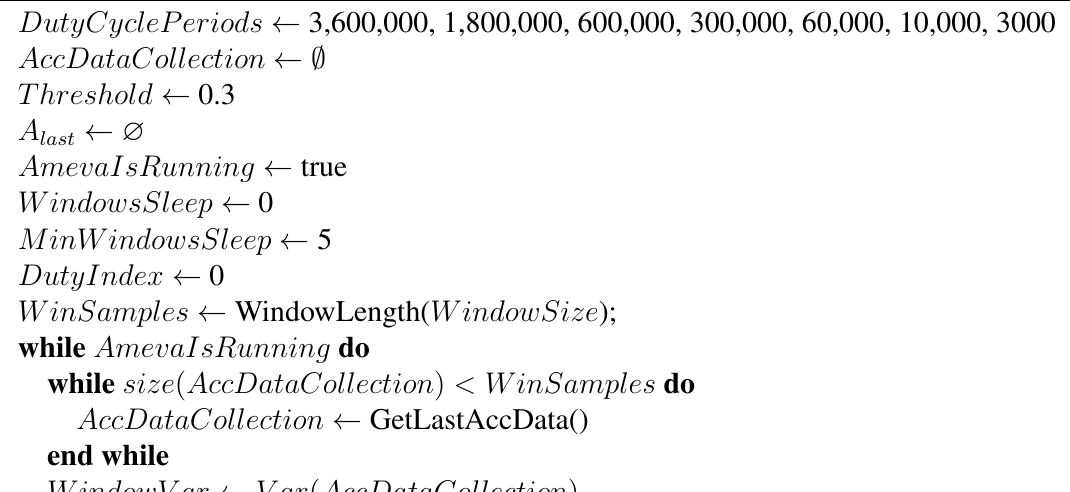
Algorithm 2 Duty cycle